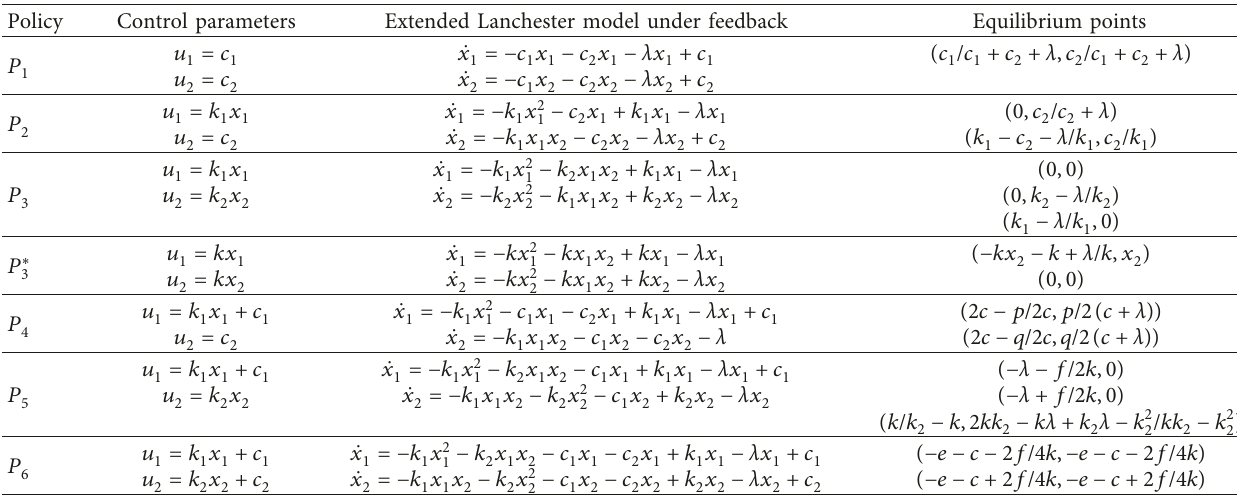
Table 5: Dynamic equations and equilibrium points for extended Lanchester model (12) under different feedback advertising policies. Policy